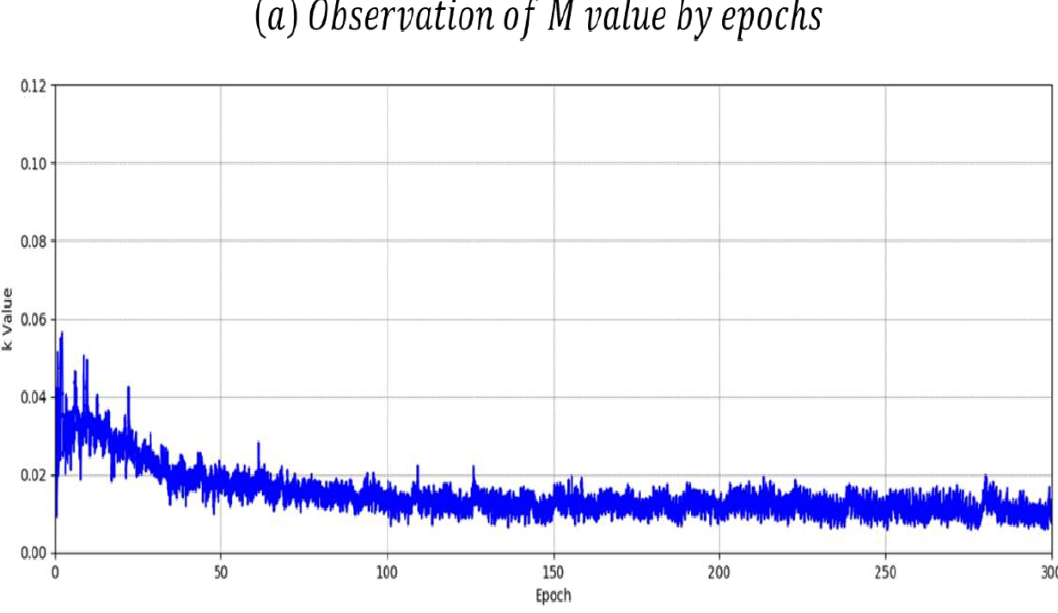
Figure 17. Convergence measurement results of the proposed model using L2 loss.